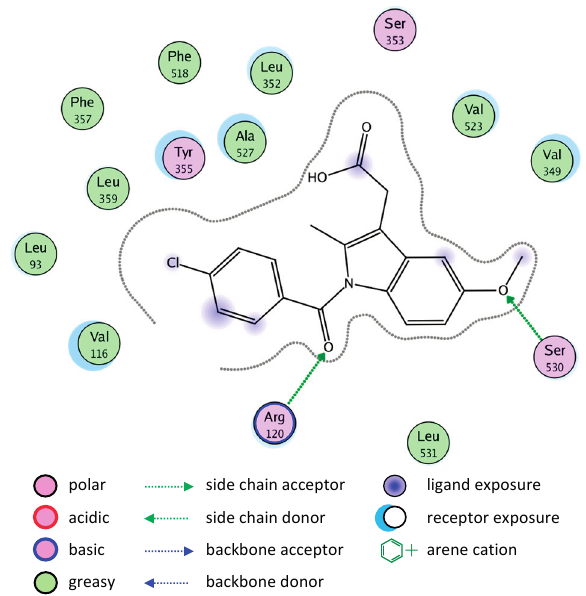
Figure 2. Docking of indomethacin (a non-selective inhibitor of cyclooxygenase COX-1 and 2) into the COX-2 active site.